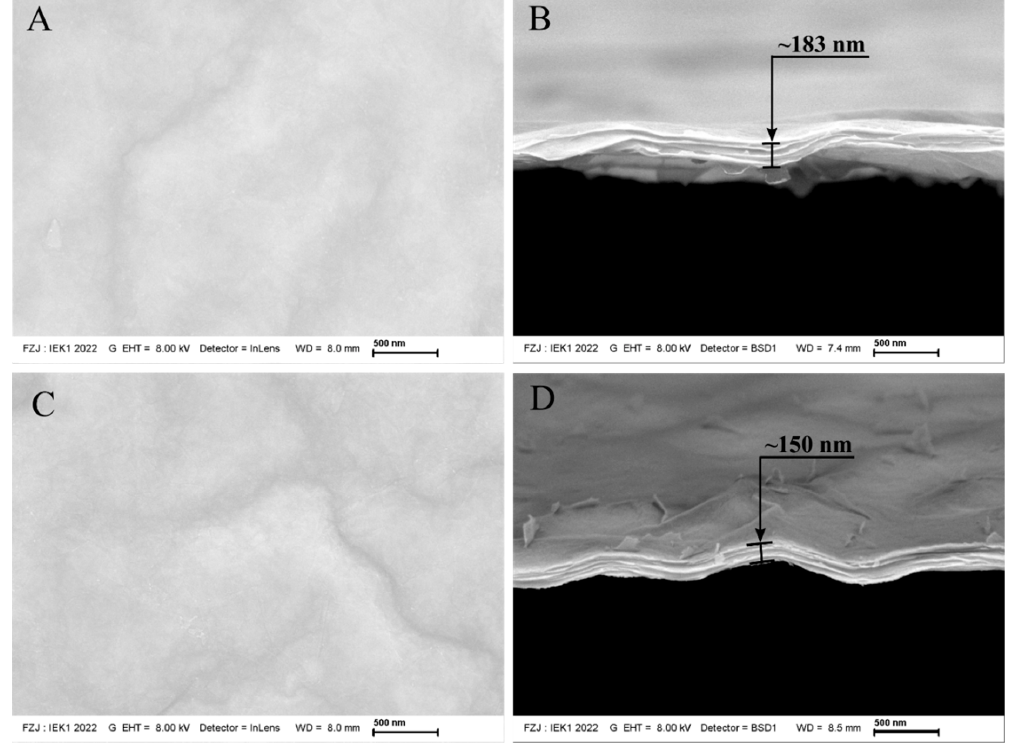
Figure 5. ( A – D ): SEM images of Ti 3 C 2 MXene membranes produced via dip coating on an α -Al 2 O 3 substrate from suspensions C 1 treated at 80 °C and 500 °C under H 2 /Ar atmosphere, respectively.